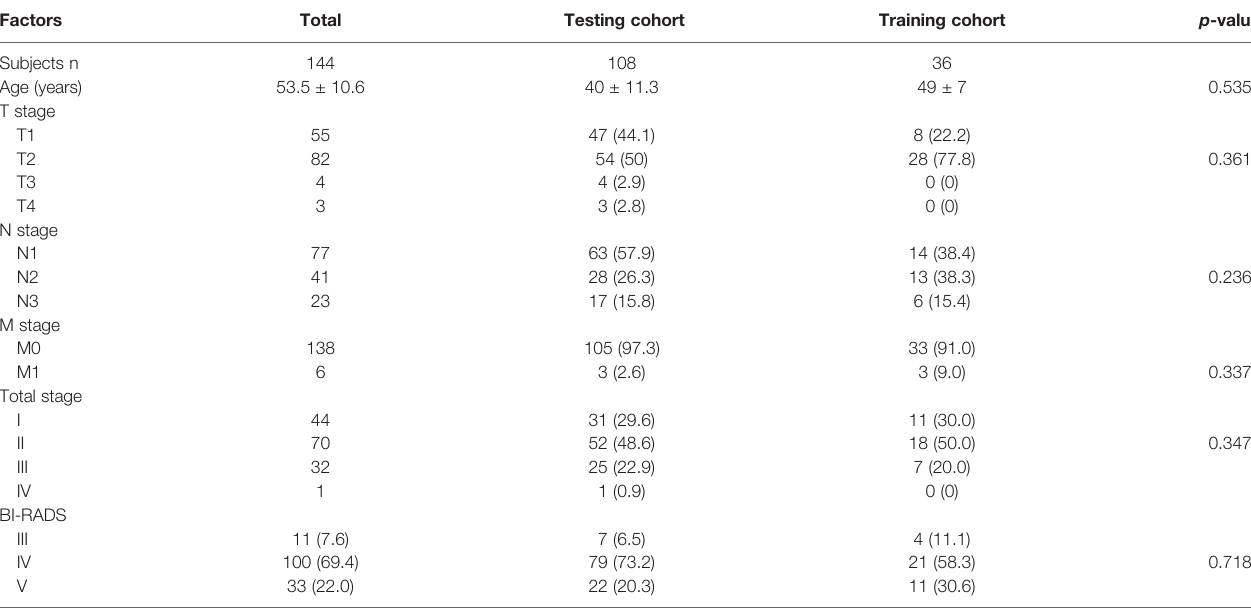
TABLE 1 | Clinical characteristics of patients in the primary and validation cohorts. Factors Total Testing